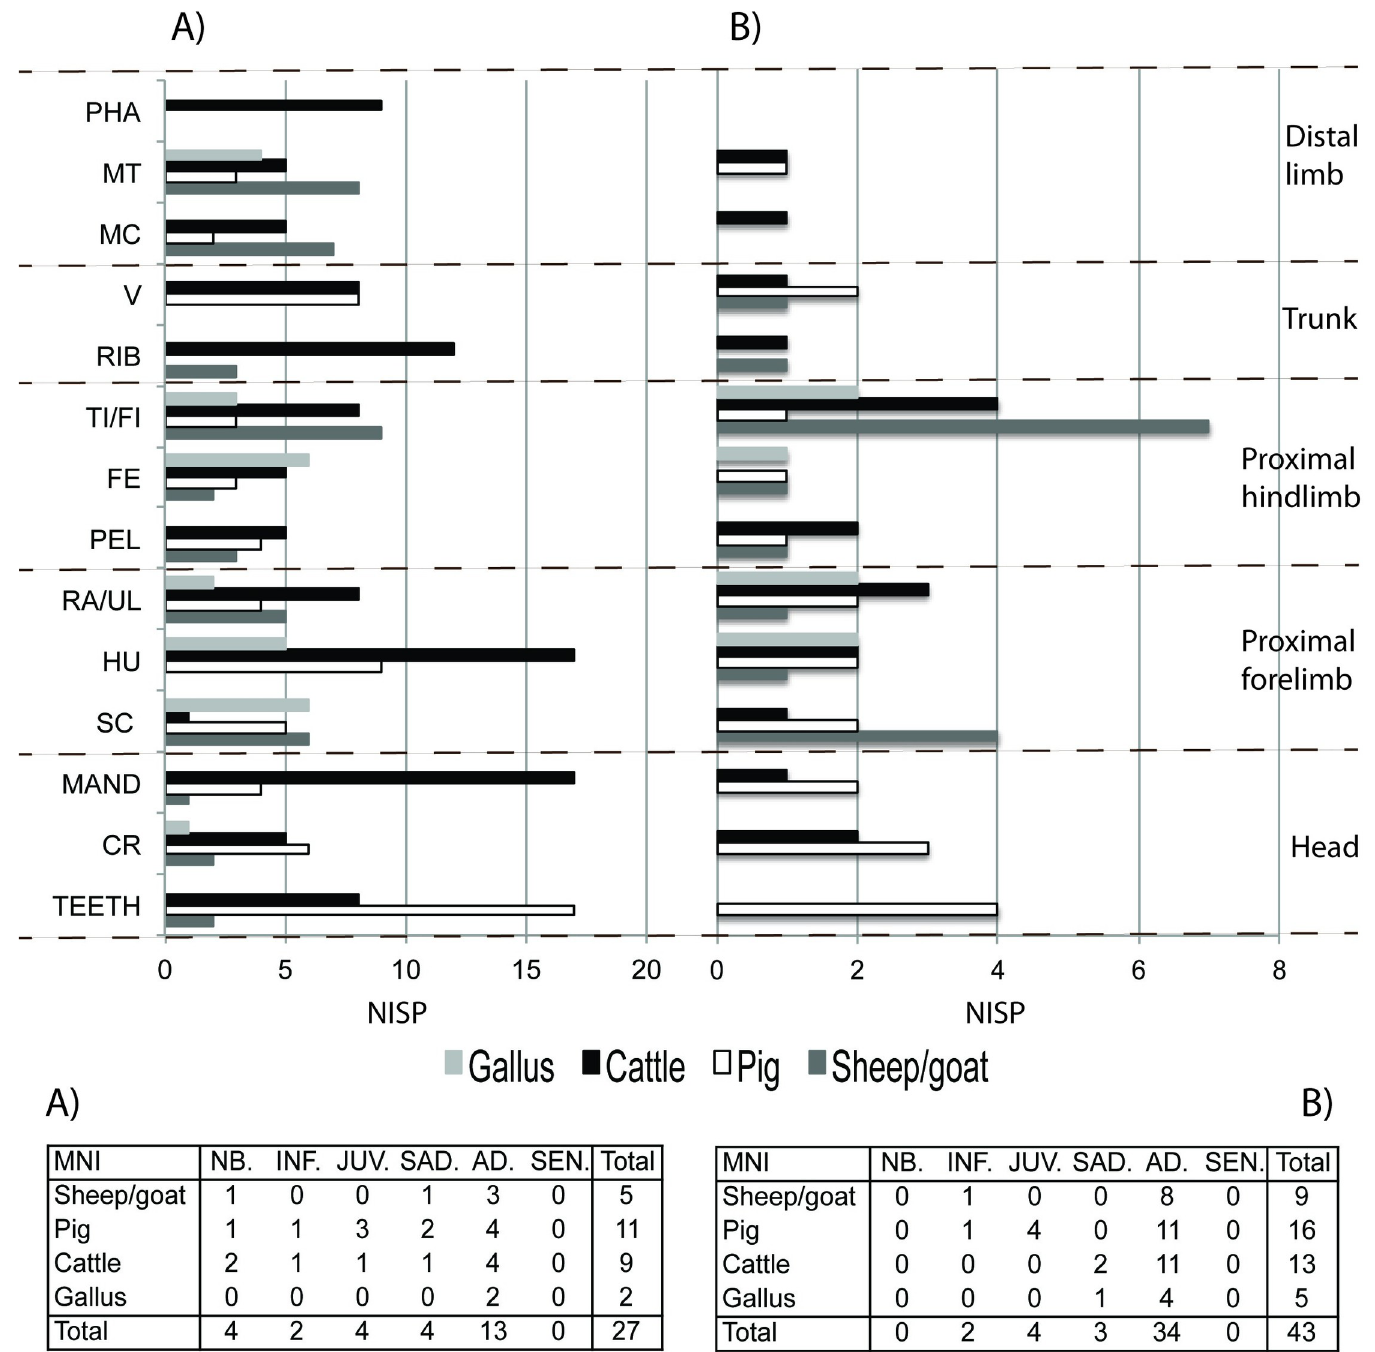
Fig 2. Distribution of body parts and minimum number of individuals by species on A) the occupation floor of the necropolis, and B) inside the graves of the Vila de Madrid necropolis. (Key: CR = cranium; MAND = mandible; V = vertebra; RIB = rib; SC = scapula; HU = humerus; RA/UL = radius/ulna; PEL = pelvis; FE = femur; TI/ FI = tibia/fibula; MC = metacarpal; MT = metatarsal; PHA = phalanx; NB = new-born; INF = infant; JUV = juvenile; SAD = sub-adult; AD = adult: SEN = senile).